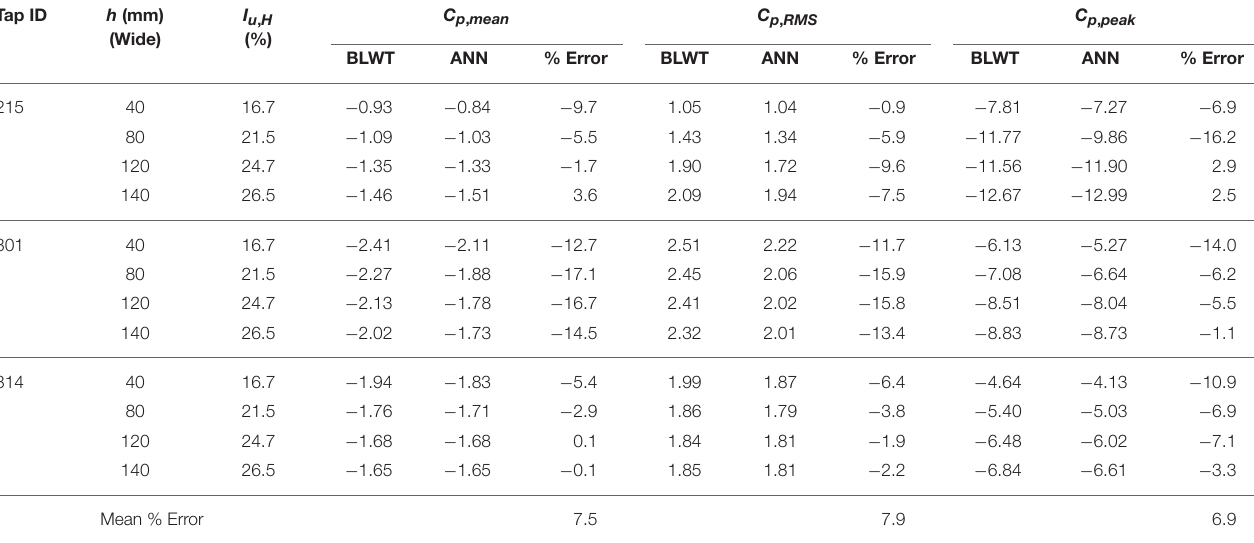
TABLE 5 | Prediction of mean, RMS, and peak pressures for taps 215, 301, and 314 on the 1:30 building model. Tap